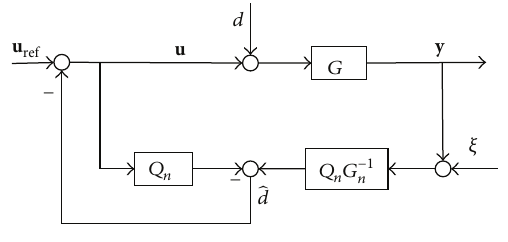
Figure 7: Classic DOB structure.